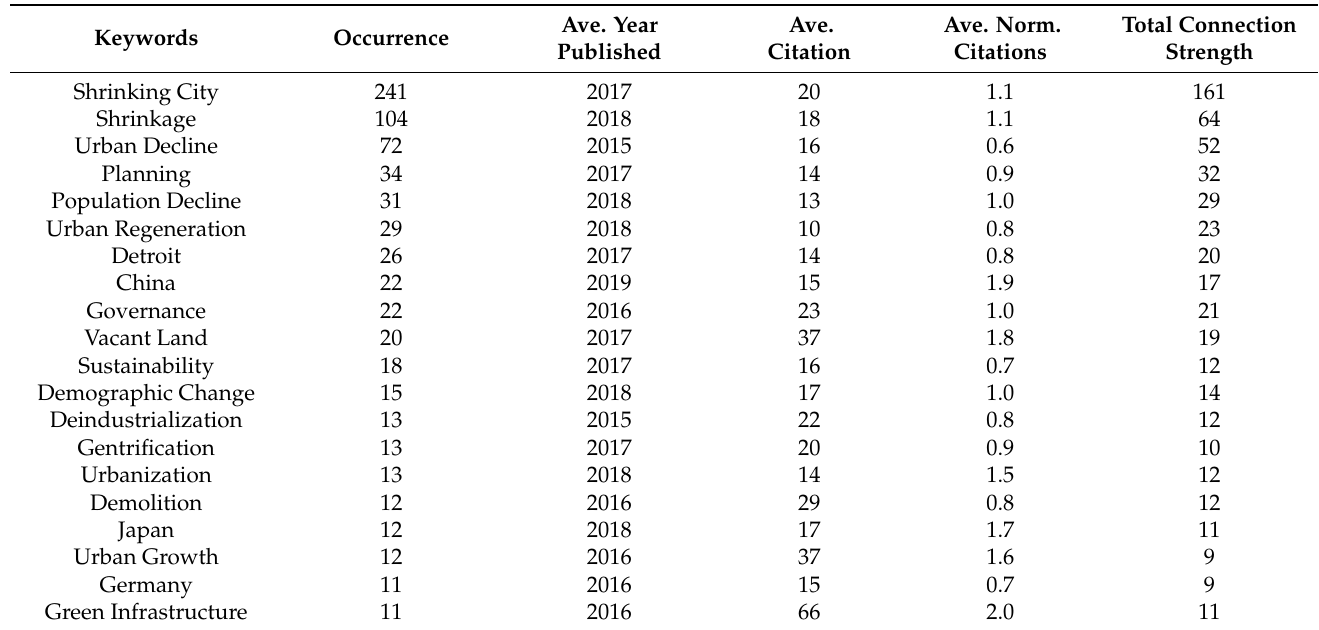
Table 5. Summaries of main keywords in